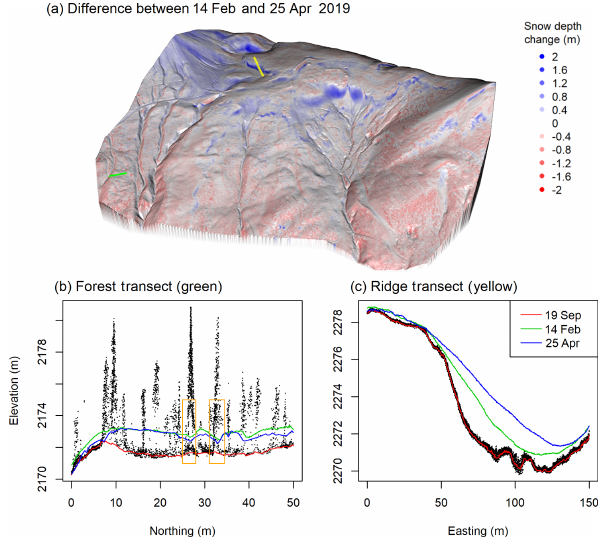
Figure 10. (a) UAV-lidar-derived snow depth difference between 13 February and 25 April 2019. Green and yellow lines in (a) cor- respond to the forest and ridge line transect locations for cross sec- tions in (b) and (c) , respectively. Cross-section figures plot the 0.5m wide point cloud cross section from the 19 September 2018 snow- free scan (black points) to show the point cloud and the processed surfaces of the UAV-lidar scans of the bare ground from 19 Septem- ber 2018 (red) and the snow surface from 14 February 2019 (green) and 25 April 2019 (blue). Orange polygons in (b) highlight loca- tions of tree